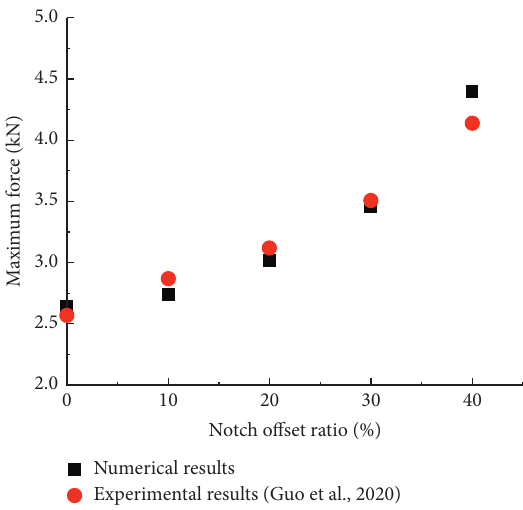
Figure 11: Experimental verification of the peak load.